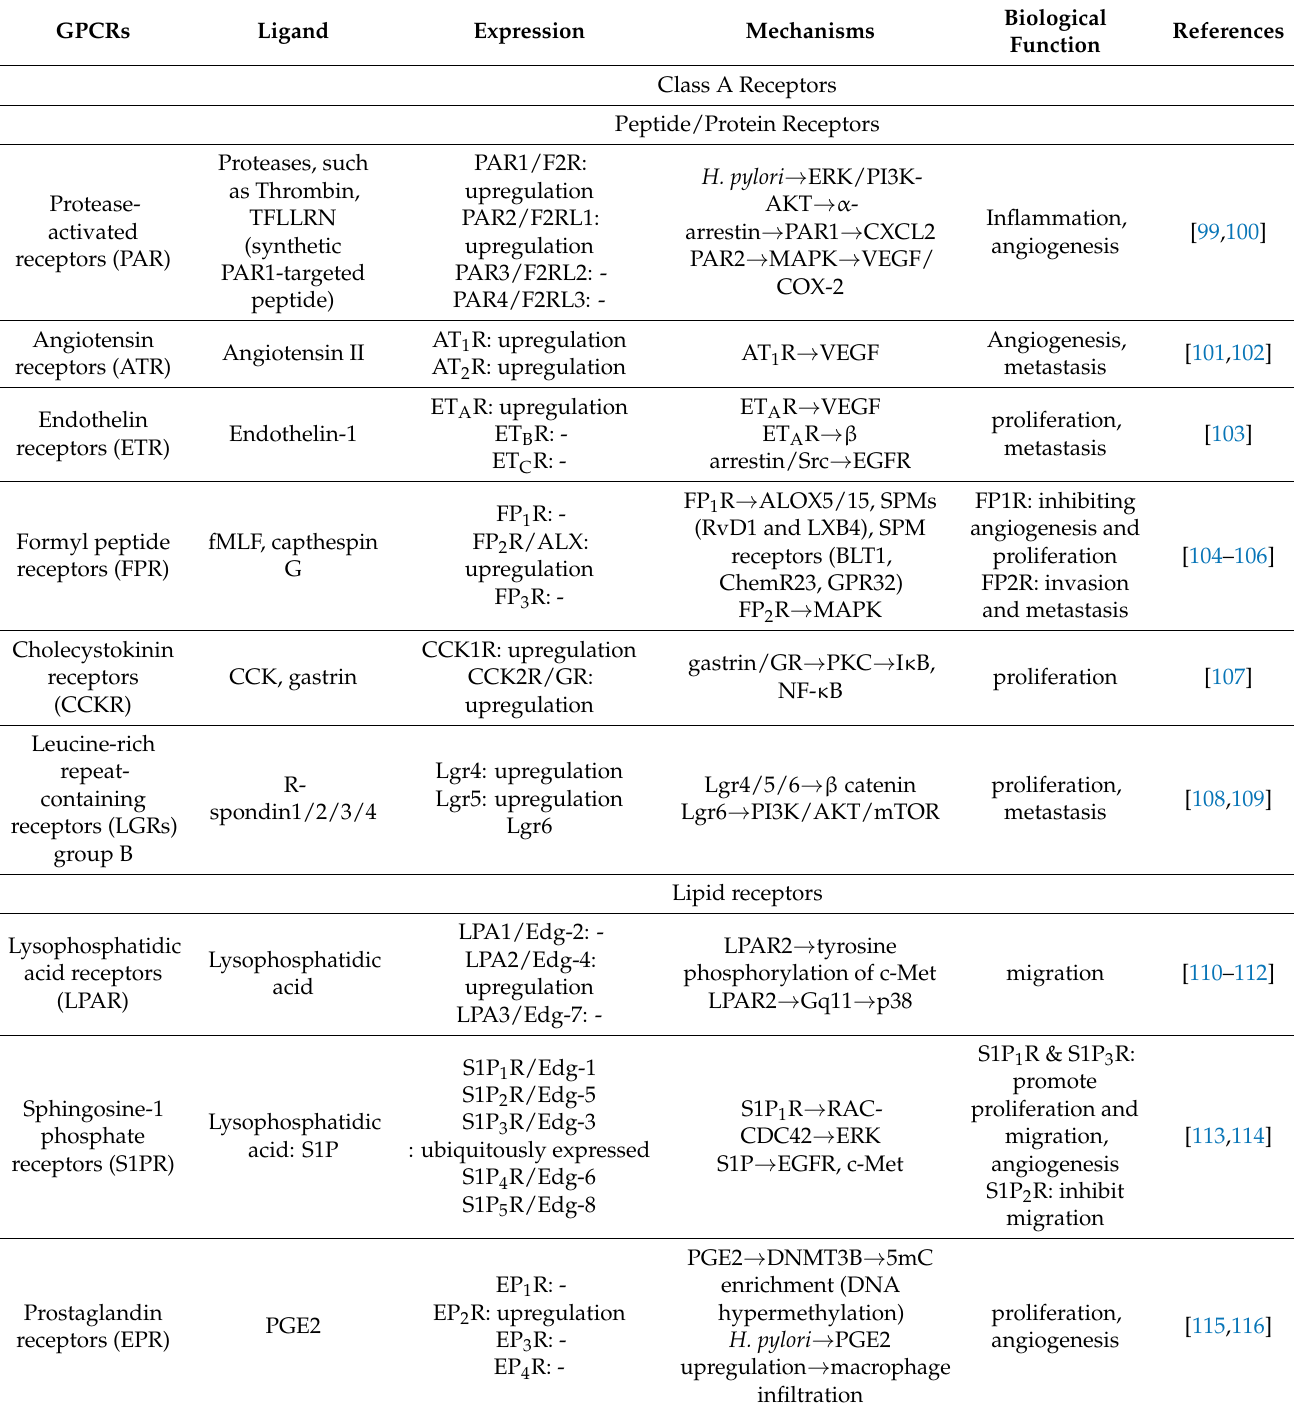
Table 1. The most reported GPCRs in